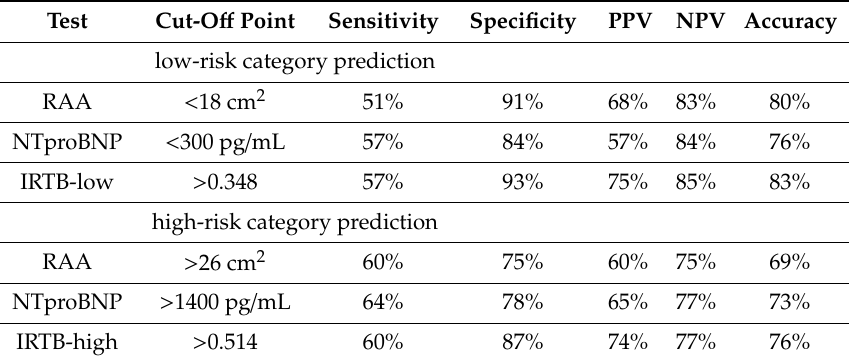
Table 4. Statistical properties of the univariate (RAA, NTproBNP) and multivariate (IRTB-low and IRTB-high) tests.